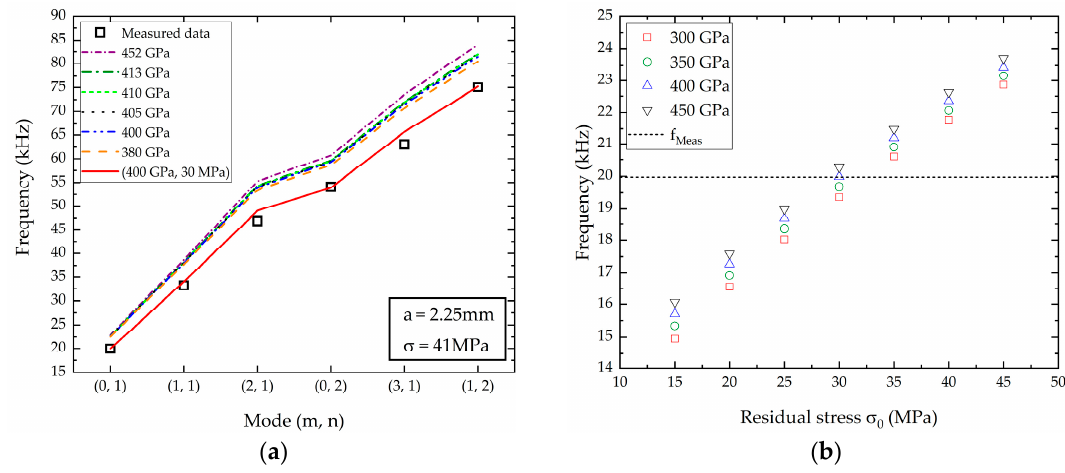
Figure 7. ( a ) Dashed lines: Computed resonance frequencies obtained with FEM calculations using the bulge test results. Solid line: Adjusted FEM calculations with the couple ( E , σ 0 ). Square symbols: Measured resonance frequencies determined with the vibrometry method; ( b ) calculated resonance frequency depending on E and σ 0 . Dot line: Measured resonance frequency for the (0, 1) mode. Symbol lines: Calculated resonance frequencies depending on the residual stress and Young’s modulus values.